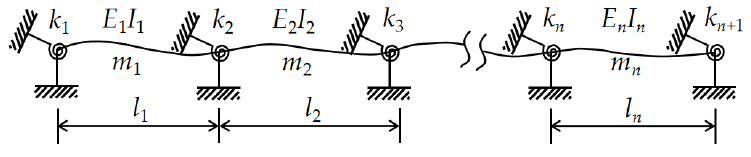
Figure 8. Multi-span cable model.